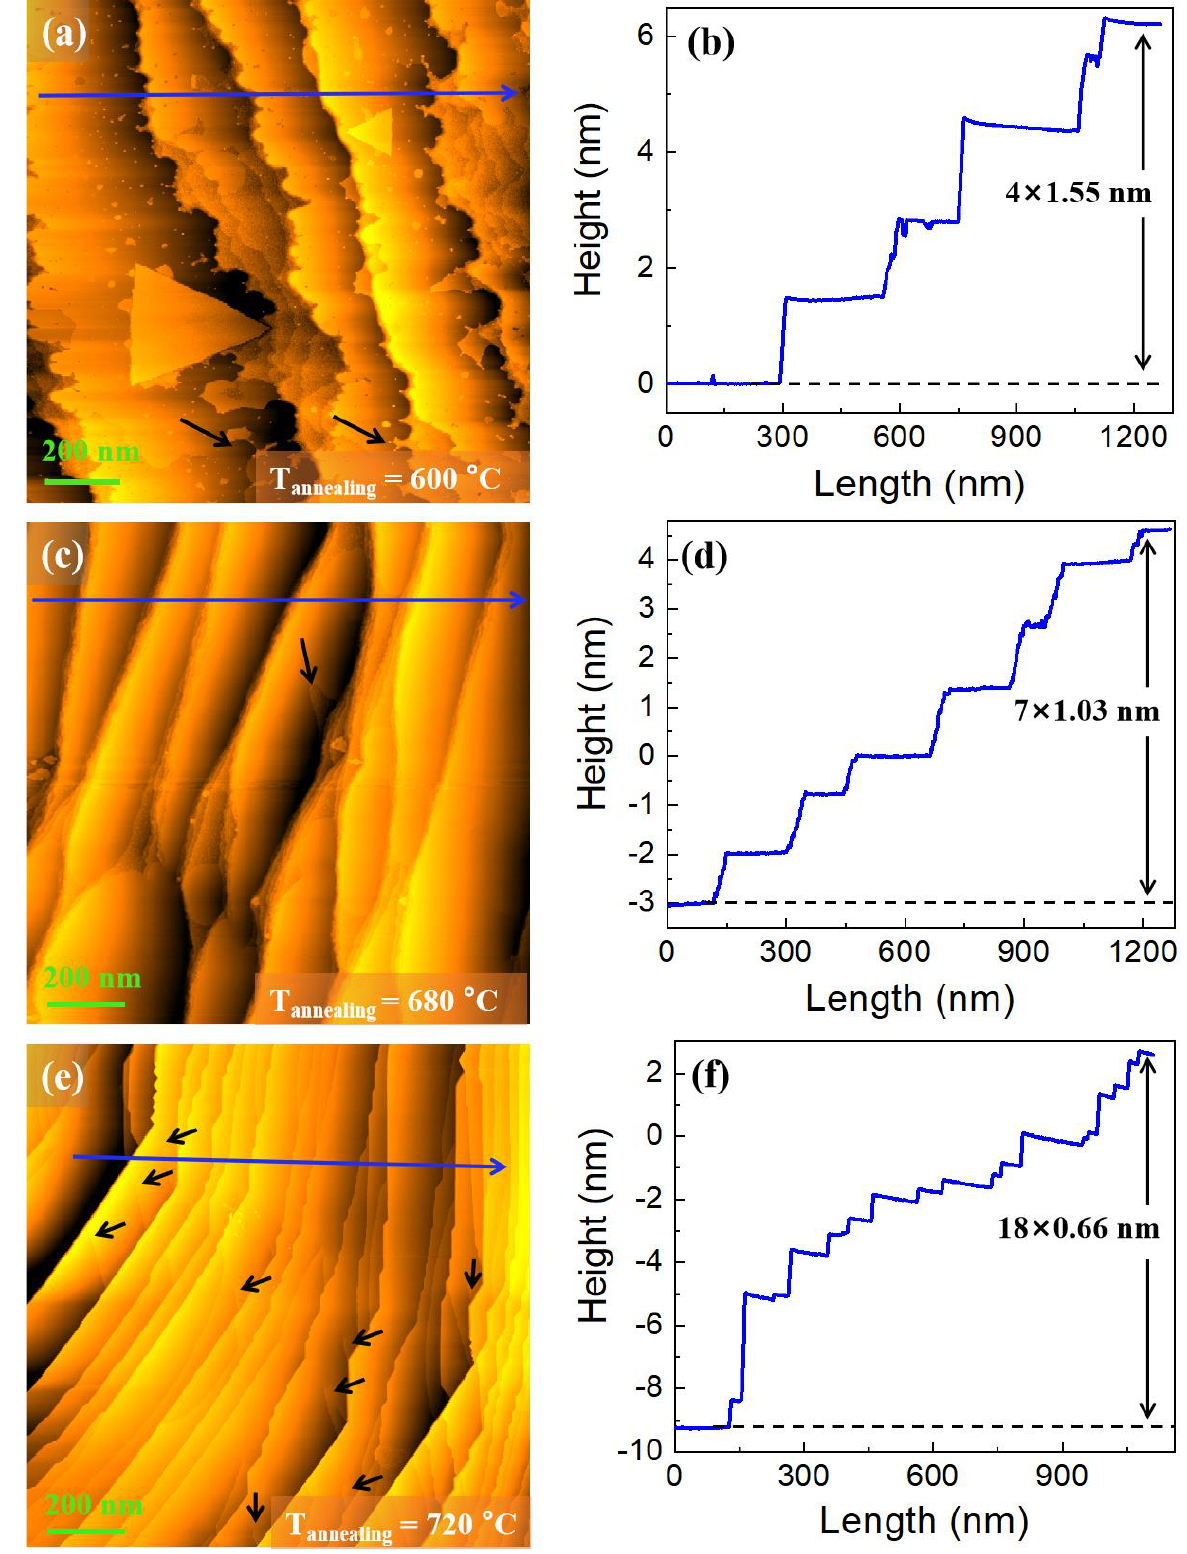
Figure 2. Morphology evolution from Process Ⅳ to Process Ⅵ . ( a , c , e ) STM images from the sample after annealing at 600 °C, 650 °C, and 720 °C, respectively, where the black arrows indicate the screw dislocations; ( b , d , f ) height profiles along the blue arrows in ( a , c , e ), respectively. Here, the scanning bias voltage and current are equal to 1 V and 0.1 nA, respectively.